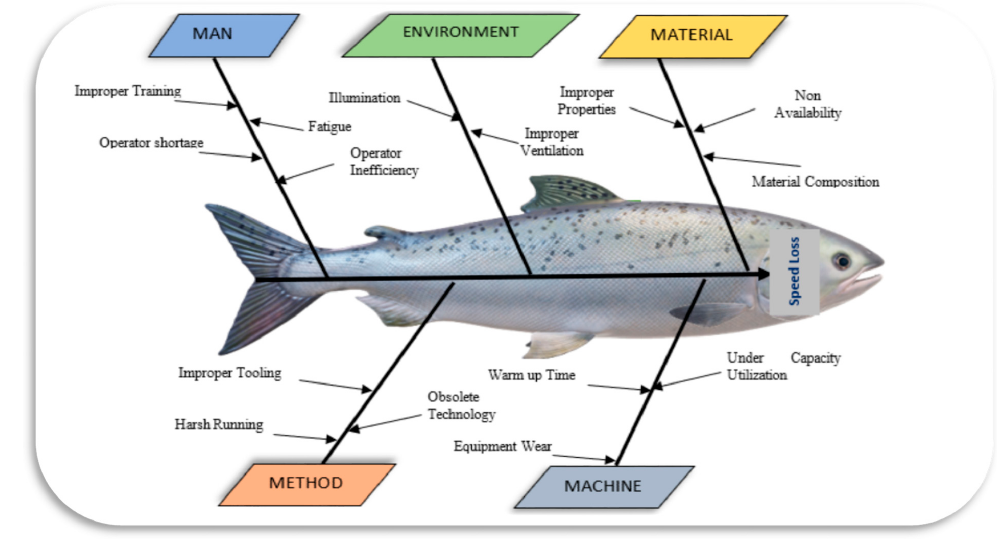
Figure 6. Fishbone diagram for speed loss.